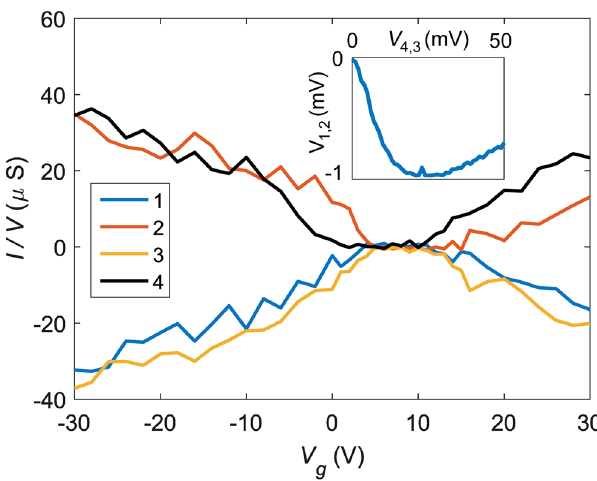
Figure 2. Theoretically calculated HBT effect ∆ + S S S /( ) are using the overlaid trace for ∆